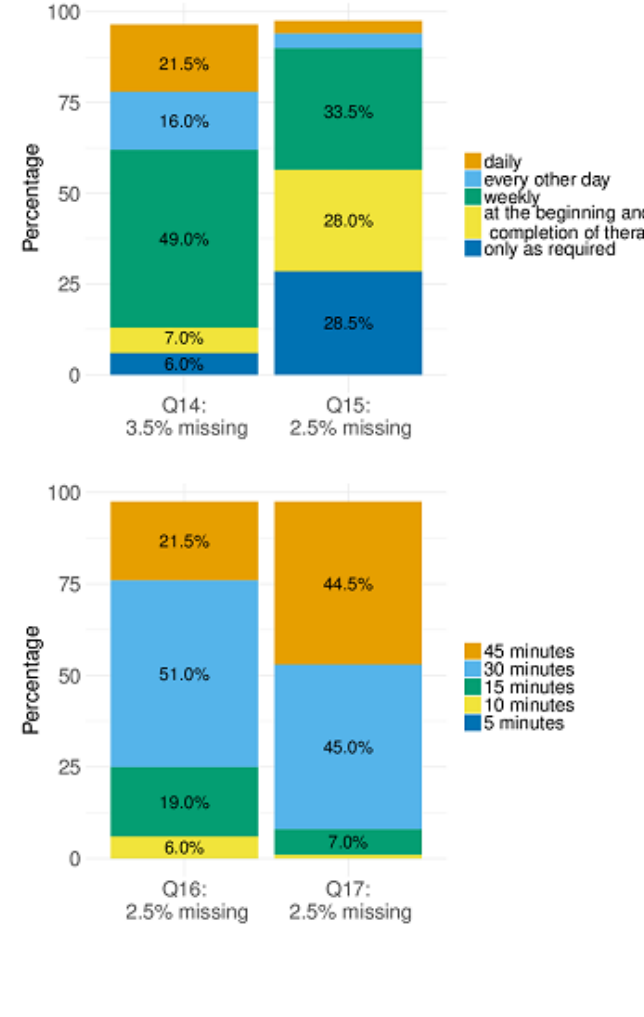
Figure 3. Distribution of the answers provided to selected questions regarding the favored frequencies of consulting a physician (Q14) or answering app-based health-related queries (Q15) as well as maximum acceptable waiting times for daily radiotherapy (Q16) or for a spontaneous medical consultation, if required